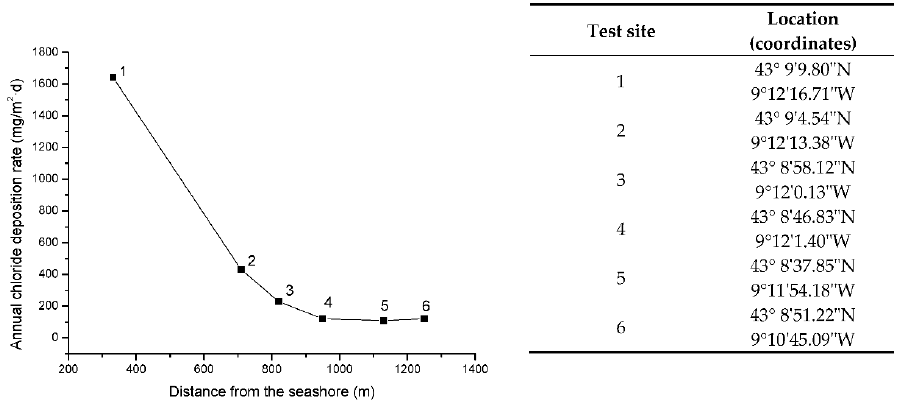
Figure 2. Variation in the annual chloride deposition rate with distance from the seashore at Cabo Vilano test sites. The numbers indicate the testing station.